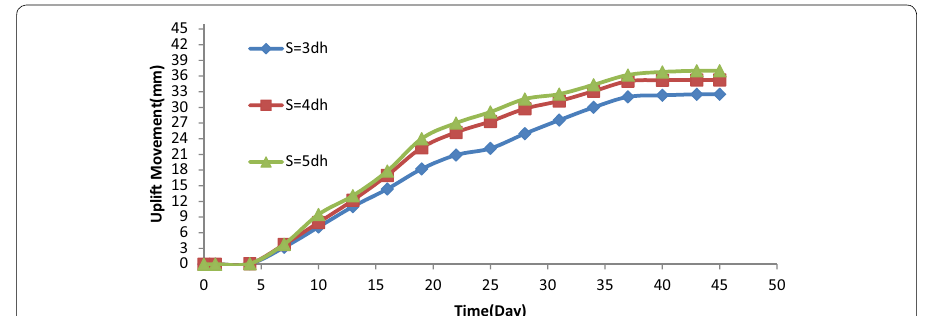
Fig. 24 Variation of uplift movement with time for pile group of L/D